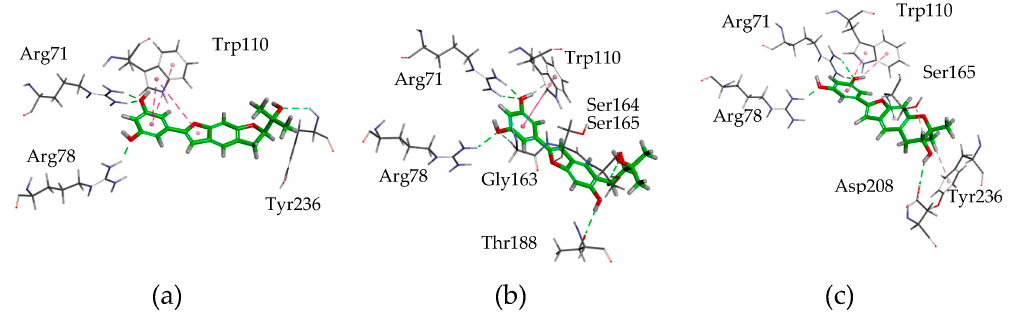
Figure 3. Binding models of moracin O ( 5 ), R ( 7 ), P ( 8 ) with the key residues of metabotropic glutamate receptor 1 (mGluR 1 ) (3KS9). ( a ) Moracin O; ( b ) moracin R; ( c ) moracin P.